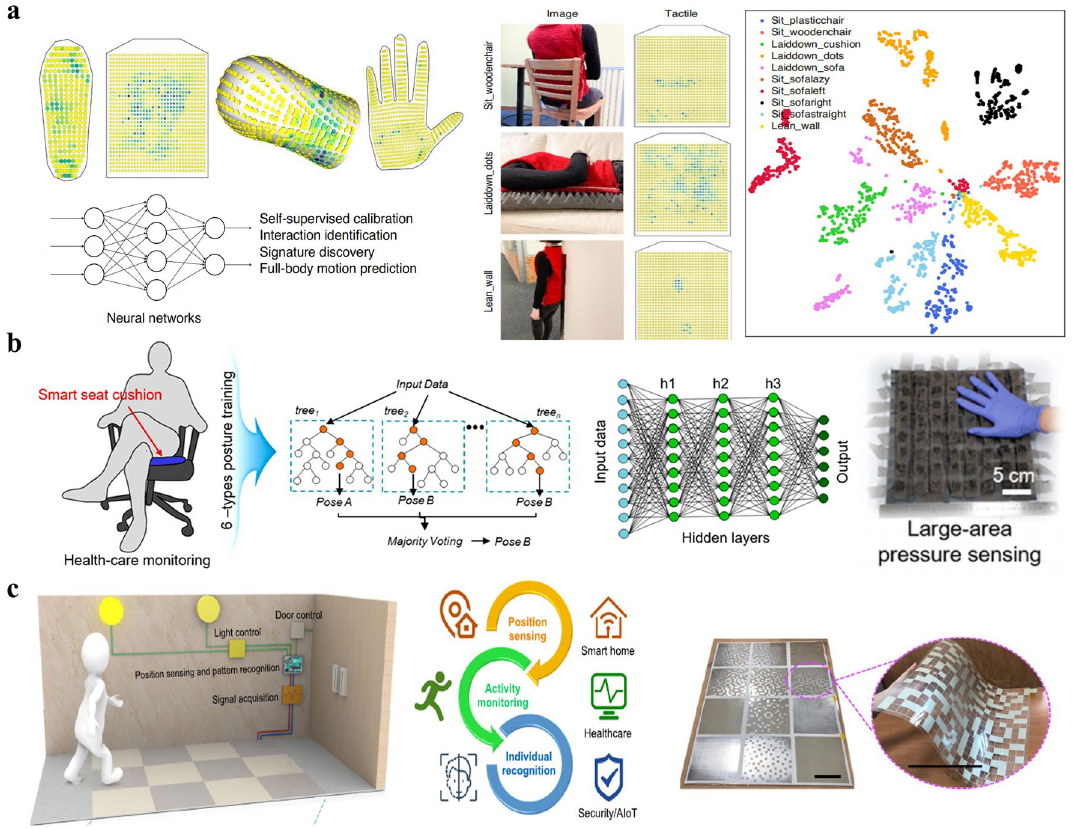
Fig. 14 a Classification of human poses, motions and other interactions with the environment by conformal tactile textiles and ML techniques [187]. Copyright (2021) Springer Nature. b Sitting posture identification of a smart seat cushion enabled by flexible piezoresistive pressure sen- sor arrays and ML techniques [189]. Copyright (2021) American Chemical Society. c Individual recognition of a smart mat enabled by flexible triboelectric pressure sensor arrays and ML techniques [21]. (2020) The